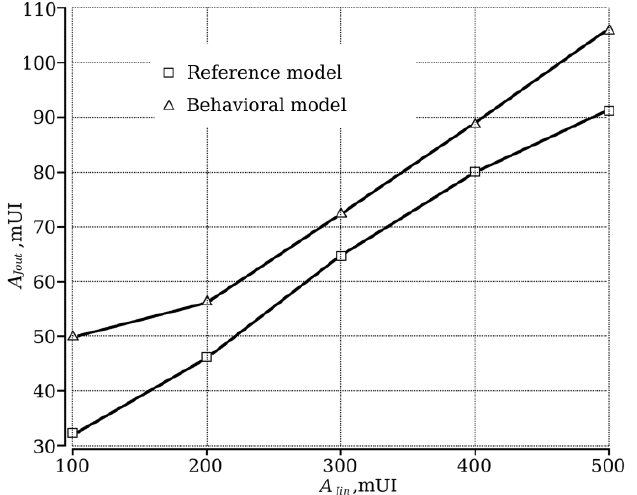
Fig. 4. The dependency of output jitter amplitude A Jout of the clock signal on the input jitter amplitude A Jin calculated using the reference (a square marker) and the behavioral (a triangular marker)